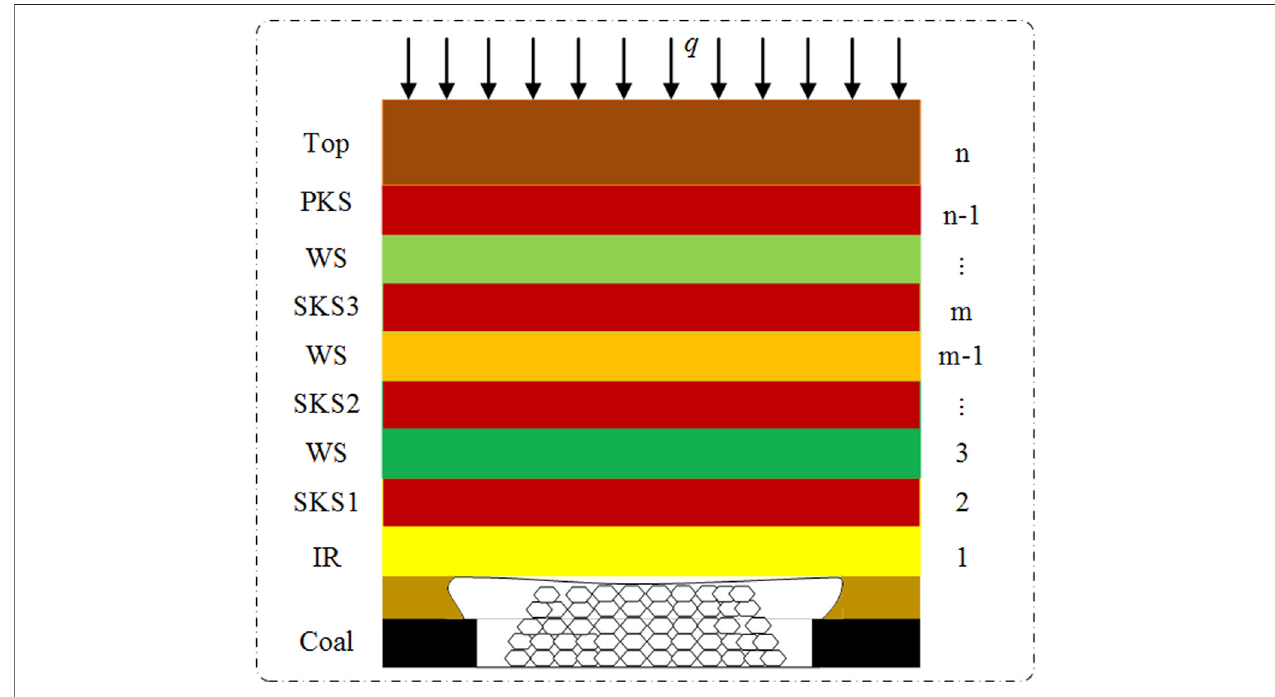
FIGURE 1 | Model of the key strata in the